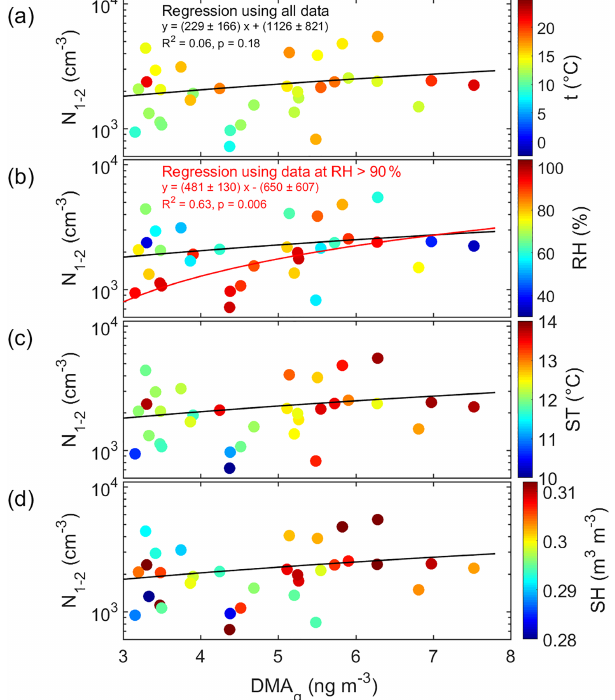
Figure 9. Cluster-mode aerosol number concentration ( N 1.1–2nm ) as a function of ammonia (NH 3 ) concentration and color-coded with (a) air temperature ( t ), (b) air relative humidity (RH), (c) soil temperature (ST), and (d) soil humidity